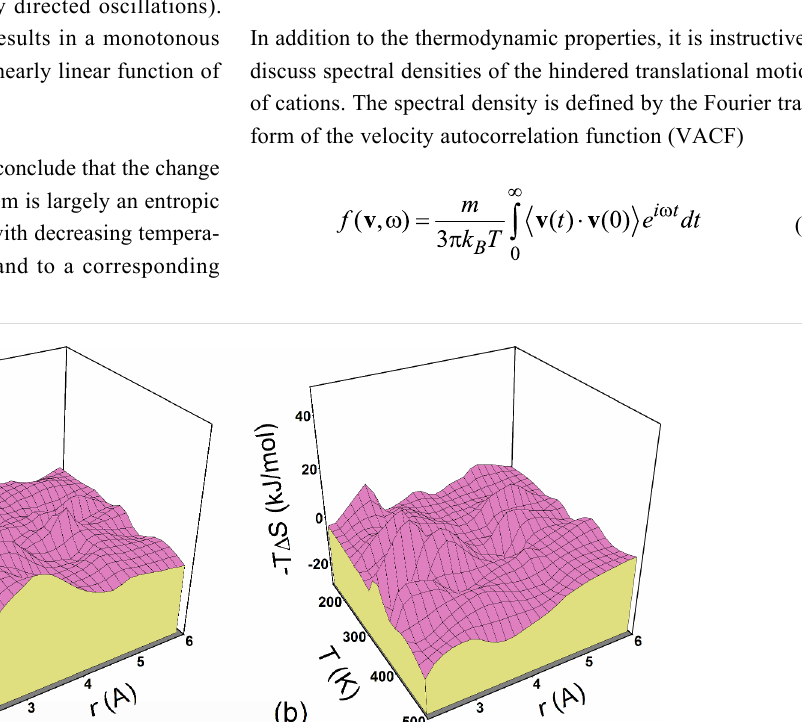
both Δ U and – T Δ S display oppositely directed